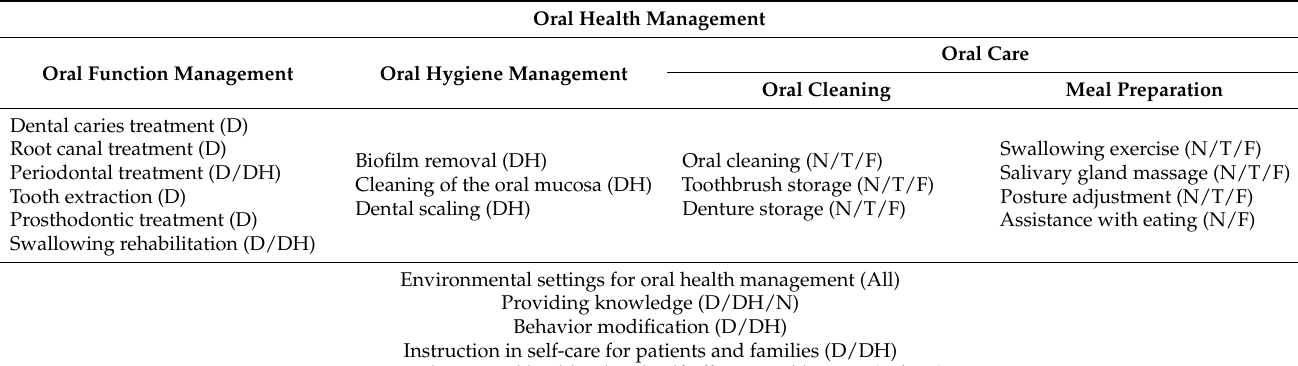
Table 1. Specific interventions for oral health management in oral cancer